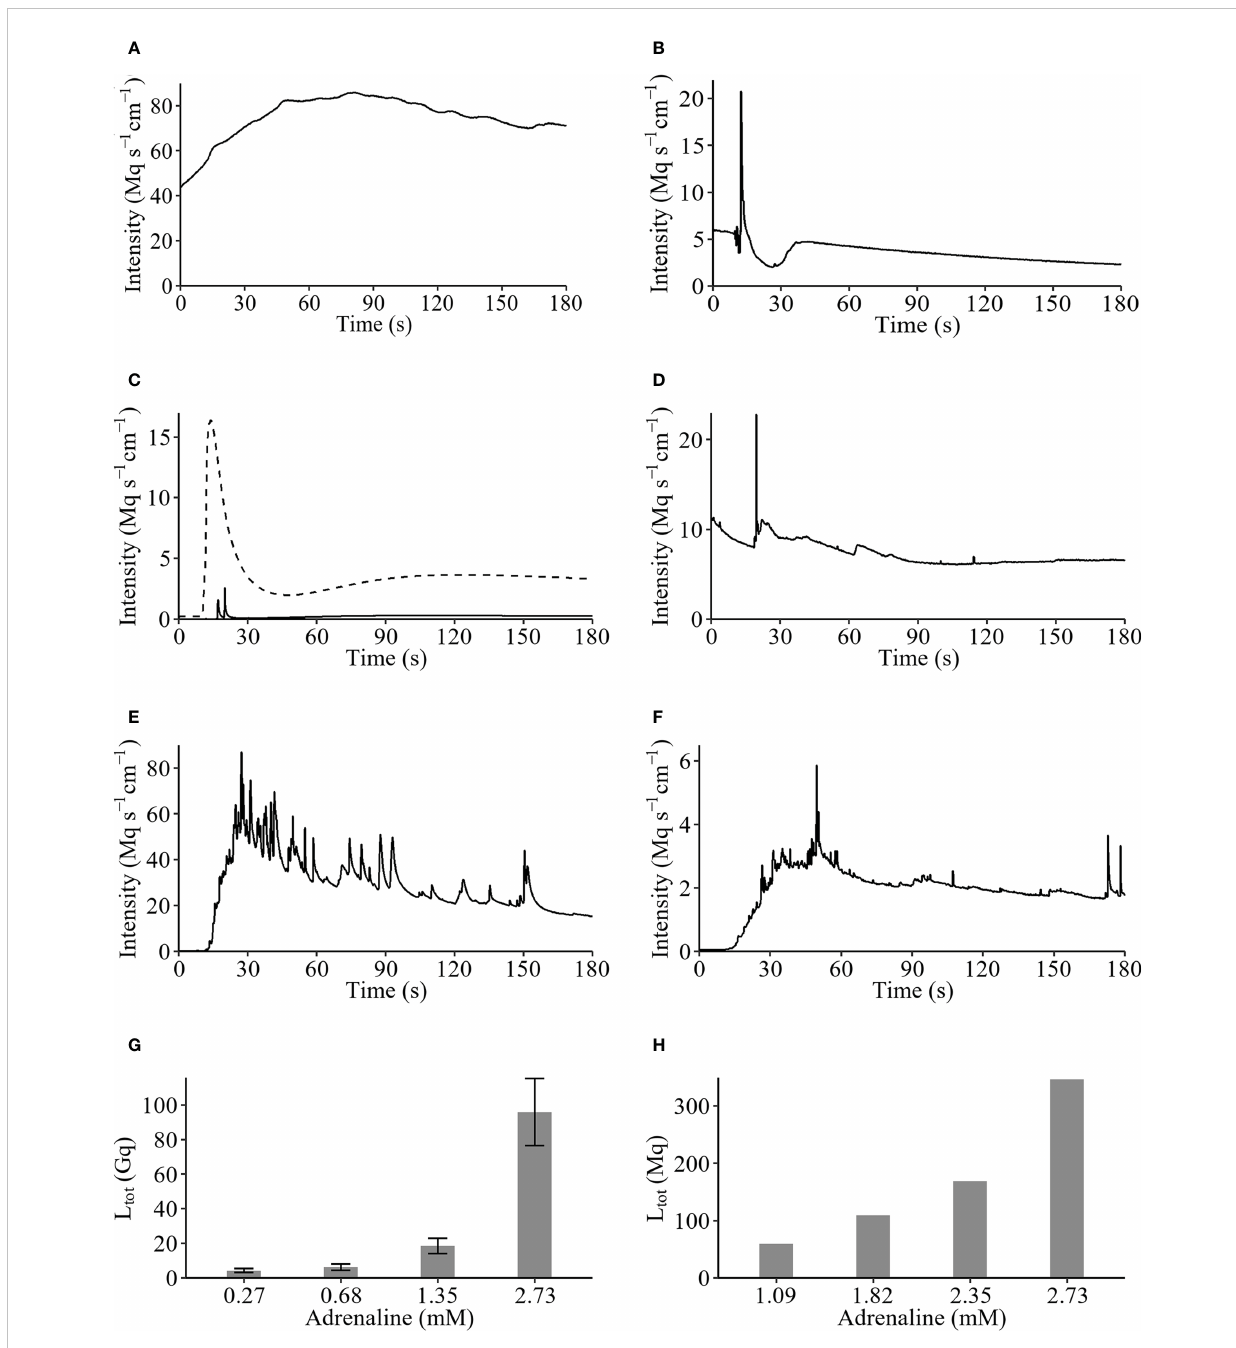
FIGURE 2 Original recordings of Crinoidea species. (A) Spontaneous luminescence of Monachocrinus cf. aotearoa ; KCl-induced luminescences of (B) Adelatelecrinus cf. vallatus arm, (C) Stiremetra breviradia arm (full line) and calyx (dotted line), and (D) Thalassometra cf. gracilis arm; adrenaline 2.7 mM stimulation on (E) S. breviradia and (F) T. cf. gracilis arms; dose-response to adrenaline for (G) S. breviradia and (H) T. cf. gracilis arms expressed as total light (L tot ) emitted during 190 seconds in Gigaquanta and Megaquanta,